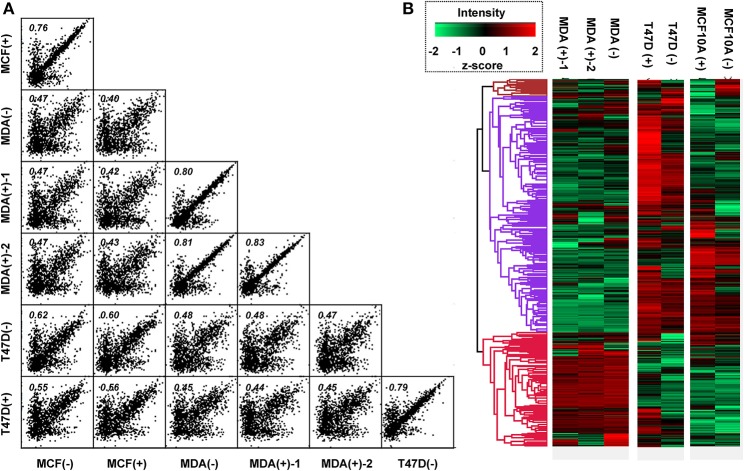
Pearson's correlation and hierarchical heatmap clustering of SPEG results. (A) Each cell line and condition was compared with each other to calculate a Pearson's Correlation coefficient. (B) A hierarchical heatmap was generated to provide global insight into the changes in and between the sialoproteomes for each type of cell upon treatment with 1,3,4-O-Bu3ManNAc. The (+) notation indicates samples treated with 100 μM of 1,3,4-O-Bu3ManNAc while (–) indicates untreated controls. Duplicate evaluation (independent biological replicates) of the MDA-MB-231 line is indicated with “-1” and “-2” [e.g., MDA(+)-1 and MDA(+)-2].